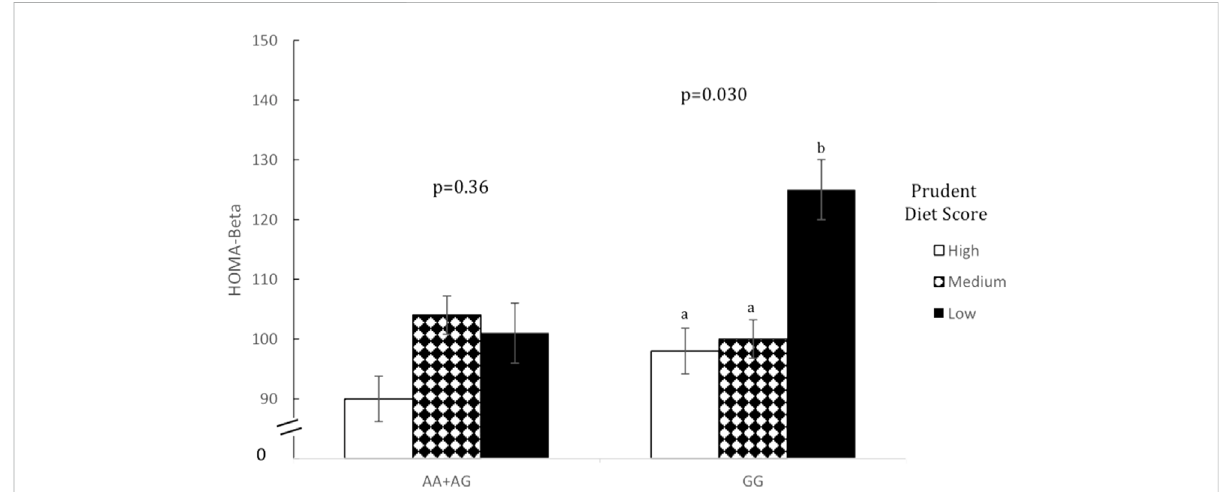
FIGURE 2 Homeostatic model assessment of beta cell dysfunction (HOMA-Beta) by prudent dietary score and 9p21 genotype (rs10757274).Data are means±SEM.Statisticalsigni fi cancewascalculatedusingunadjustedANOVAinitiallyfortheinteractiontermofgene-dietinallsixgroups( n =1309, p =0.044),andthenseparatelyforprudentdietaryscoreinthosewithAA+AGgenotype( n =985, p =0.360)andthosewithGGgenotypeseparately ( n = 324, p = 0.030). In the GG group, those with high (75th percentile) and medium (26th-74th percentile) prudent dietary score had a signi fi cantly lowerHOMA-Betathanthosewithlow(25thpercentile)prudentdietscore( p =0.013and p =0.023respectively).IntheAA+AGgroupHOMA-Betadidnotdiffer betweenanyoftheprudentdietaryscoregroups( p =0.080and p =0.235,respectively).Differentletters(a versus b)indicatepairwisedifferencesbetweengroup means that were statistically different while same letters indicate pairwise comparison were not statistically